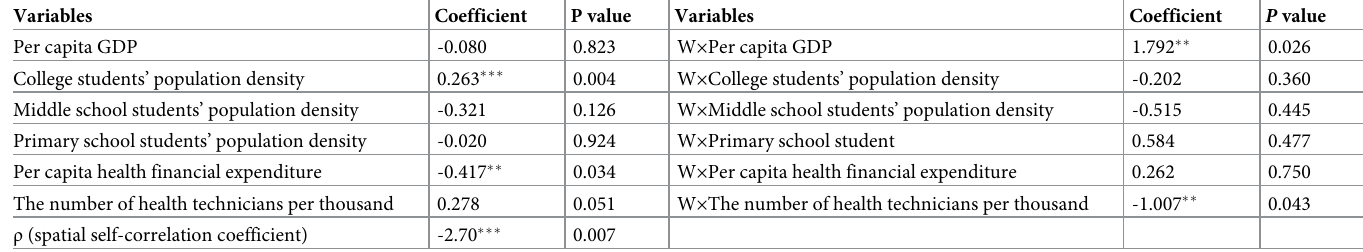
Table 2. Spatial Durbin model estimation